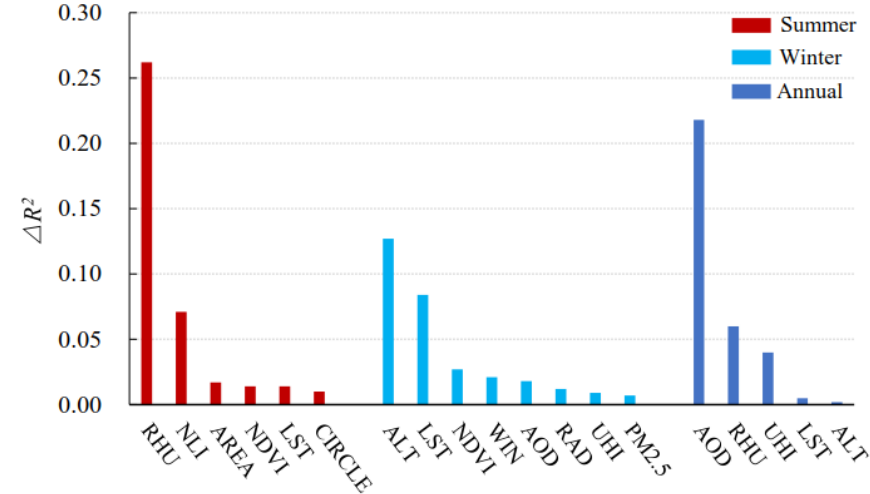
Figure 8. Ranking of influencing factors by season.